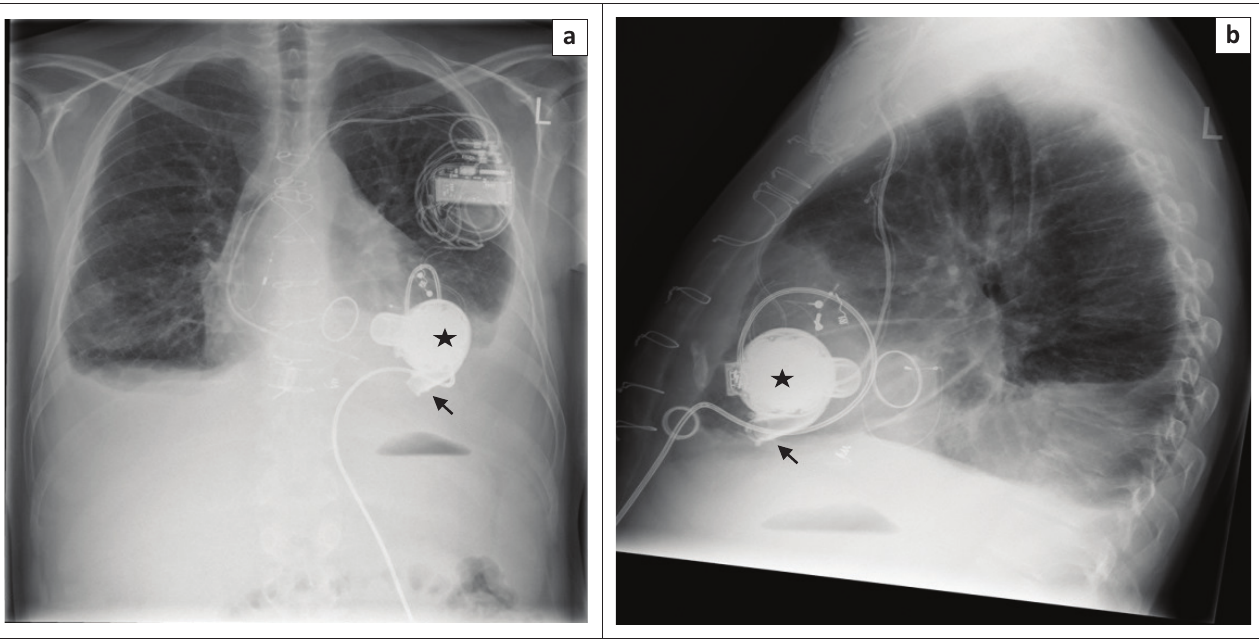
FIGURE 9: Frontal (a) and lateral (b) chest radiographs showing a HeartWare left ventricular assist device in a 41-year-old male with familial dilated cardiomyopathy. Note that its outflow cannula (arrow) is without angulation and it has a circular impeller unit